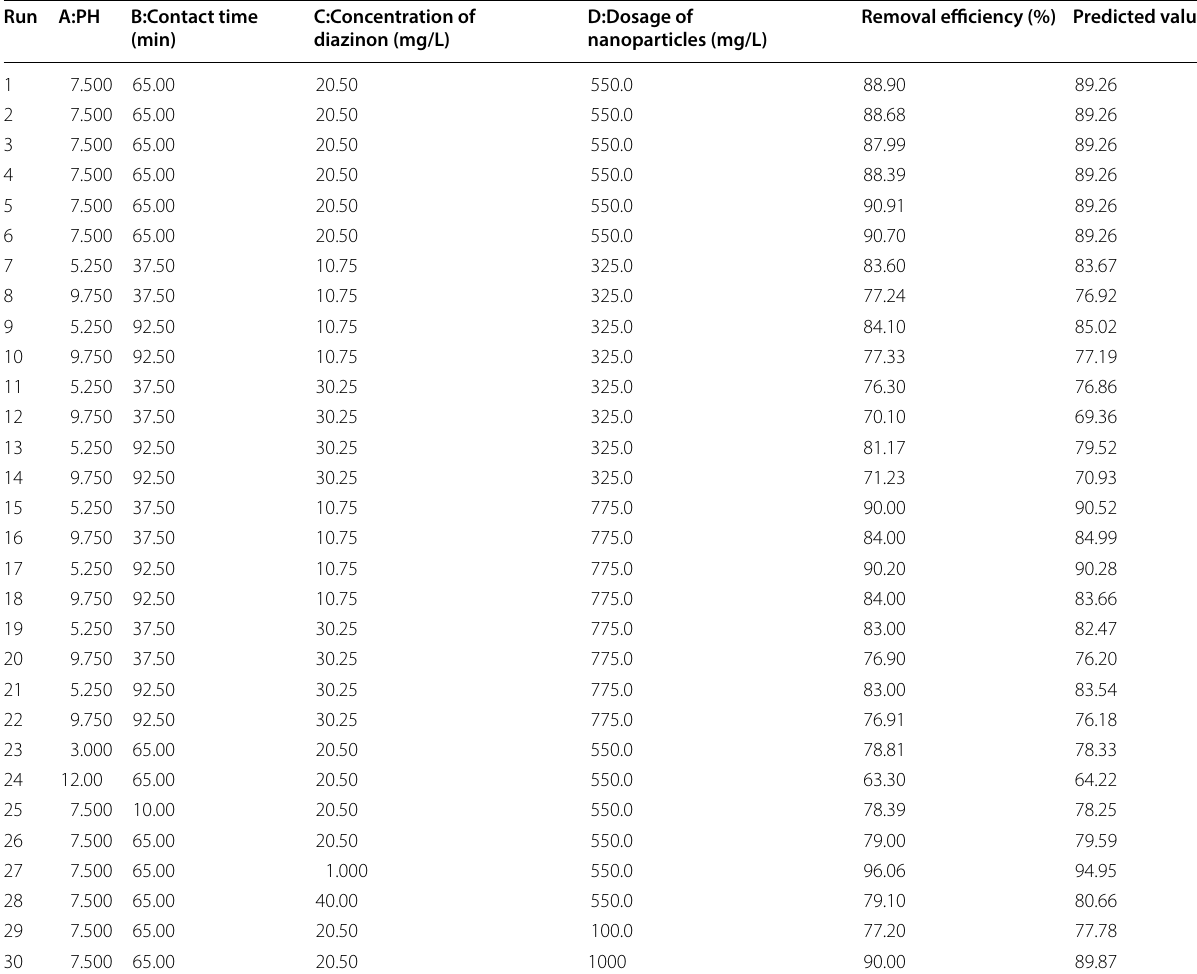
Table 3 Results of the experimental runs based on the central composite design